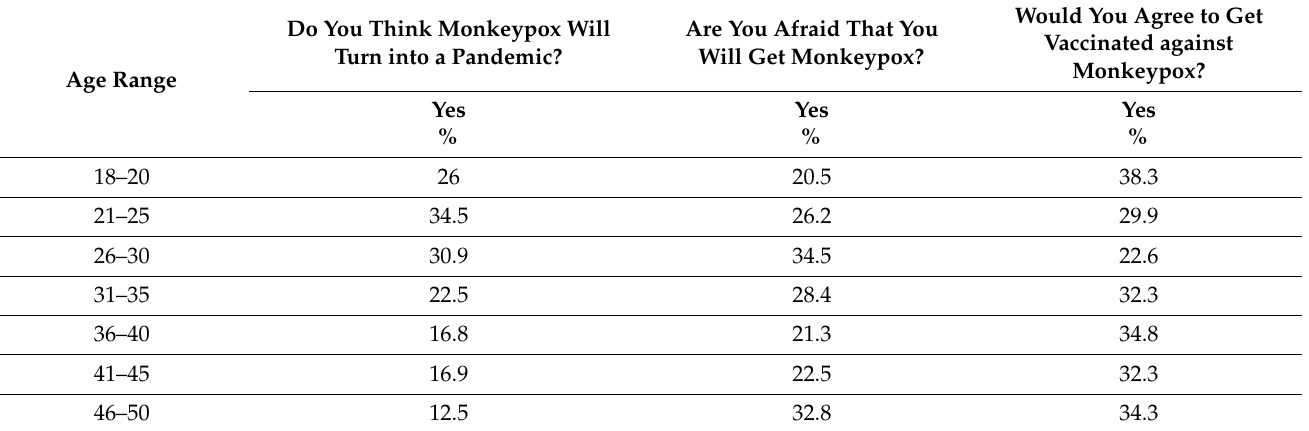
Table 5. Participants’ opinion on